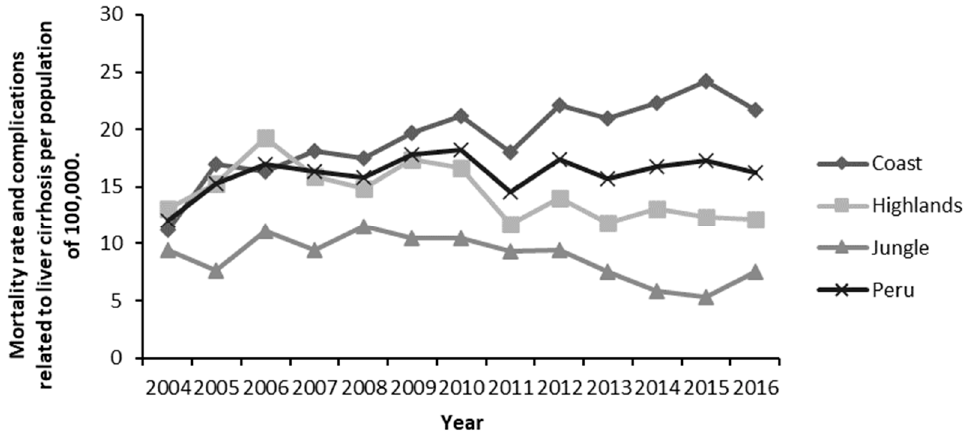
Figure 2. Trends of mortality rate and complications related to liver cirrhosis for the period 2004–2016 according to region and registered year of death for the period 2004–2016.